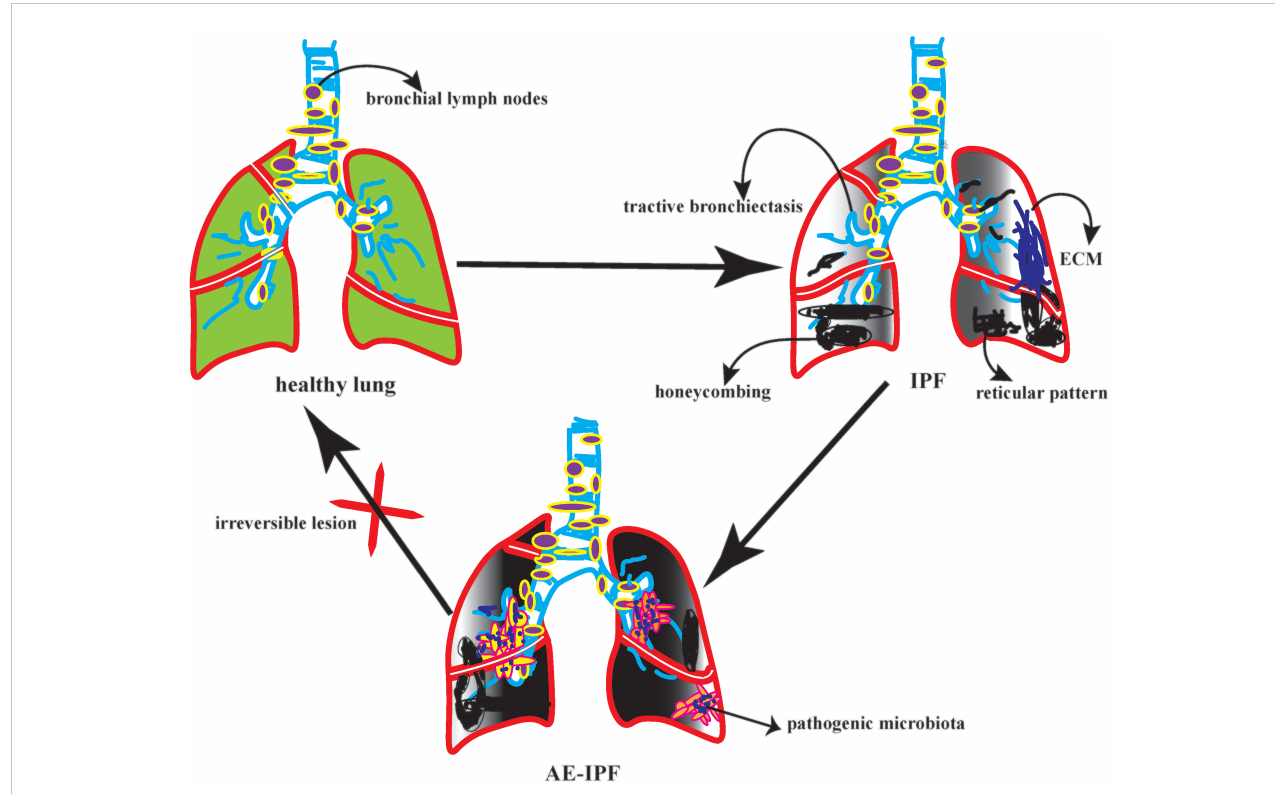
FIGURE 1 The picture depicted the different pulmonary microbiota in various state of